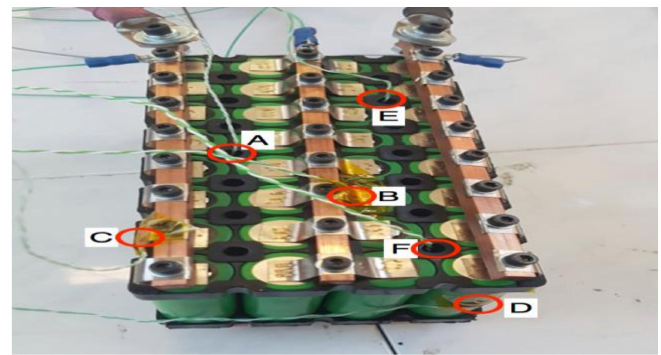
Figure 12. Battery pack with high voltage.